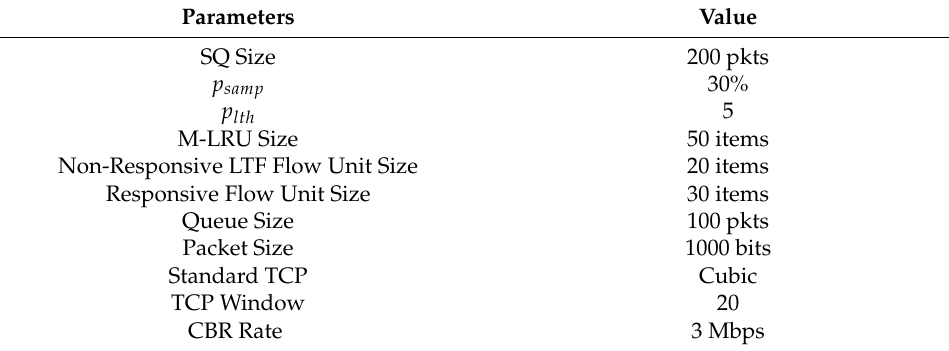
Figure 9. Network topology. Table 1. Experimental default